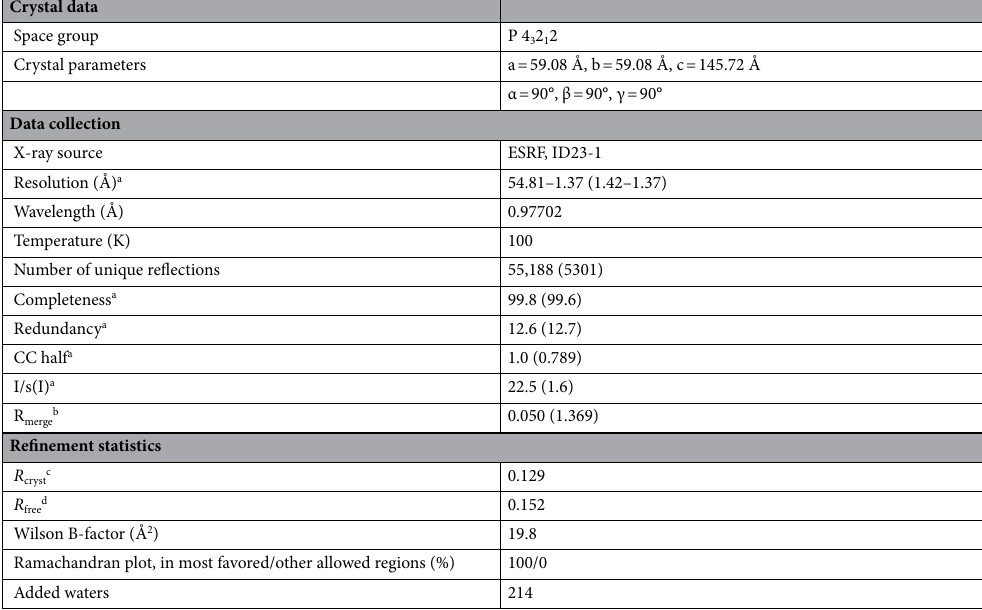
Table 1. Crystal data, diffraction data and refinement statistics for the Sc LPMO10D CD structure (PDB code 7ZJB). a Values for outer shell in paranthesis. b R sym = (cid:31) | I − � I �| / (cid:31) I c R cryst = (cid:31) ( | F obs |−| F calc | )/ (cid:31) | F obs | d R free is the R cryst value calculated on the 5% reflections excluded for